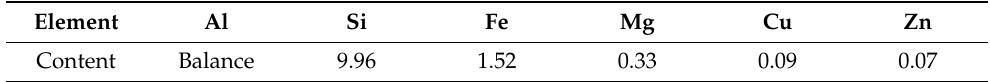
Table 1. Composition of the experimental